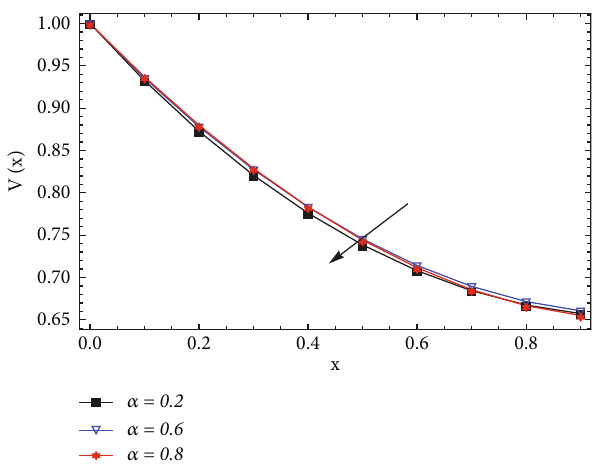
Figure 1: In lifting case e ff ect of α on V ð x Þ where g = 1 are fi xed.